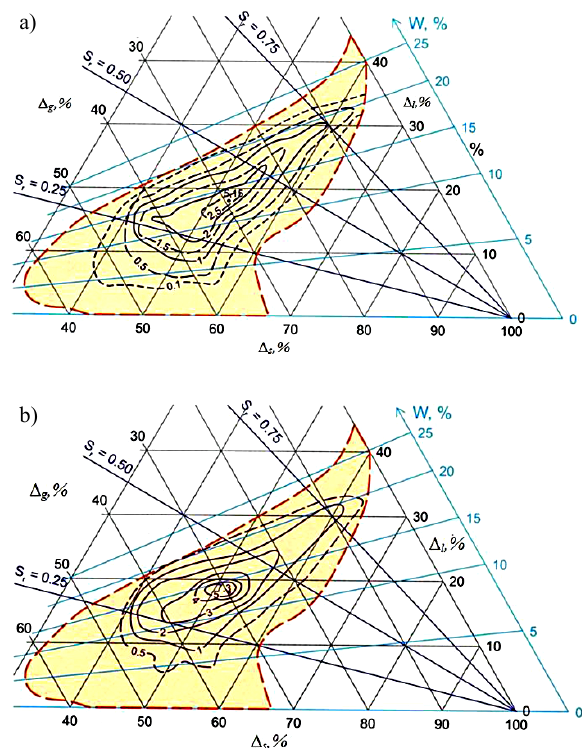
Fig. 4. Diagrams of moisture-transfer coefficient values ( D w ) and thermo-transfer coefficient values ( D Т ) depending on sand phase composition: a – D w ·10 –3 , cm 2 /s; b – D T ·10 –6 , cm 2 /dg·s